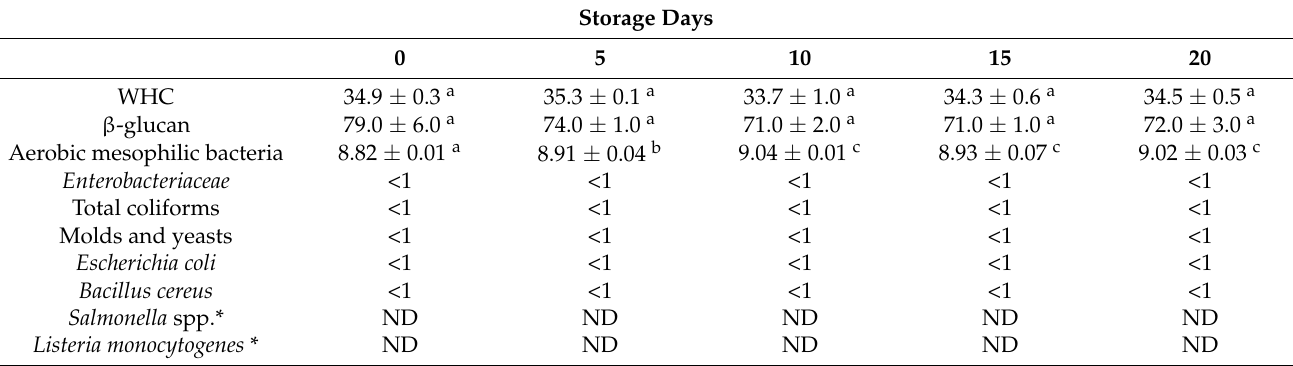
Table 5. Water holding capacity (WHC, %), content of β -glucan (mg/100 mL) and viable counts (Log CFU/mL) of lactic acid bacteria, aerobic mesophilic bacteria, Enterobacteriaceae , total coliforms, molds and yeast, E. coli , B. cereus , Salmonella and L. monocytogenes in SOFB during storage at 4 ◦ C for 20